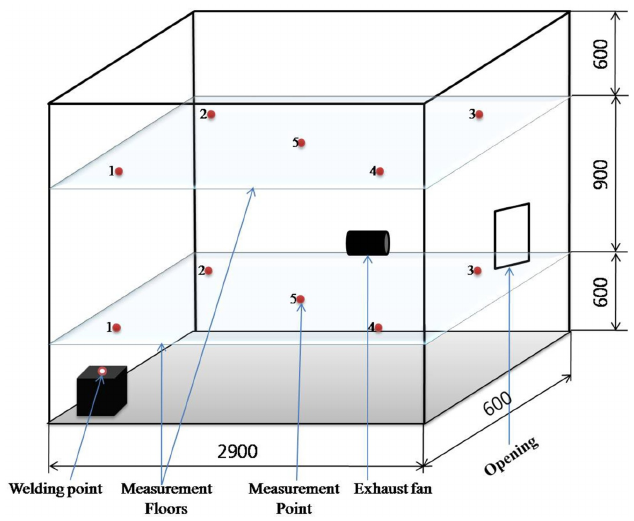
Figure 2. Schematic diagram of experimental setup and measurement points.